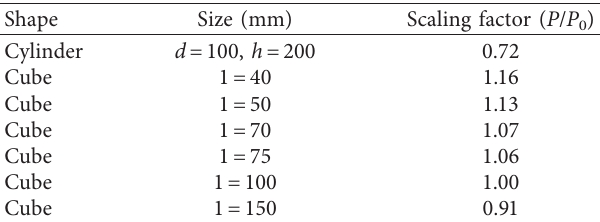
Table 2: Scaling factor of compressive strength of concrete under different dimensions.